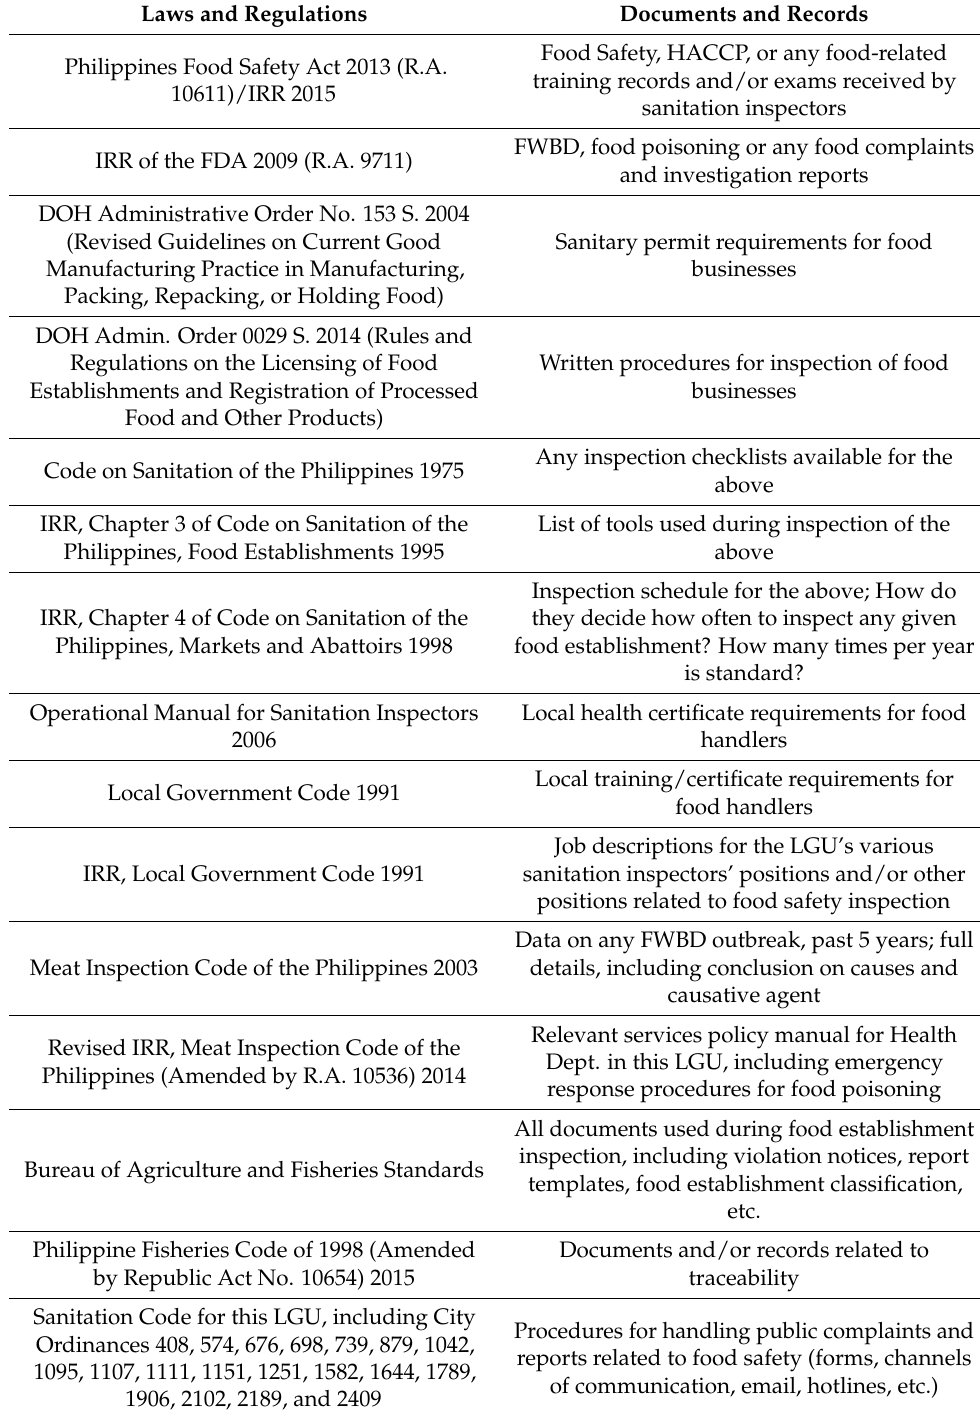
Table 1. Laws, regulations, documents, and records suggested for